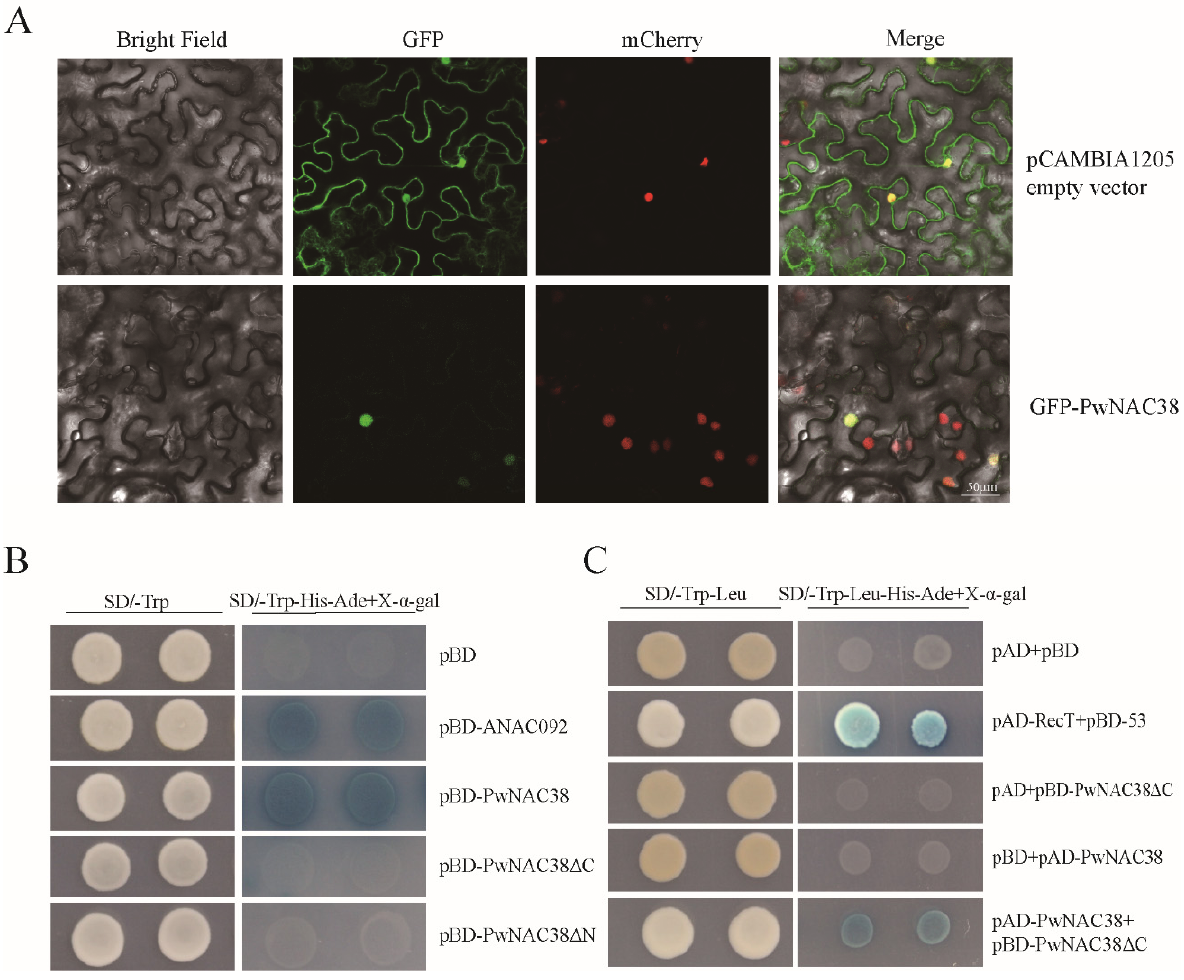
Figure 2. Functional verification of PwNAC38 . ( A ) Subcellular localization assay. Transgenic tobacco with nucleus-located mCherry expression was used as the positive control. The bar in the image represents 50 µm. ( B ) Yeast trans-acting activity assay. pBD-ANAC092 was used as the positive control, and an empty pBD vector was used as the negative control. ( C ) Yeast two-hybrid assay for PwNAC38 forming homodimers. pAD-RectT+pBD-53 were used as the positive